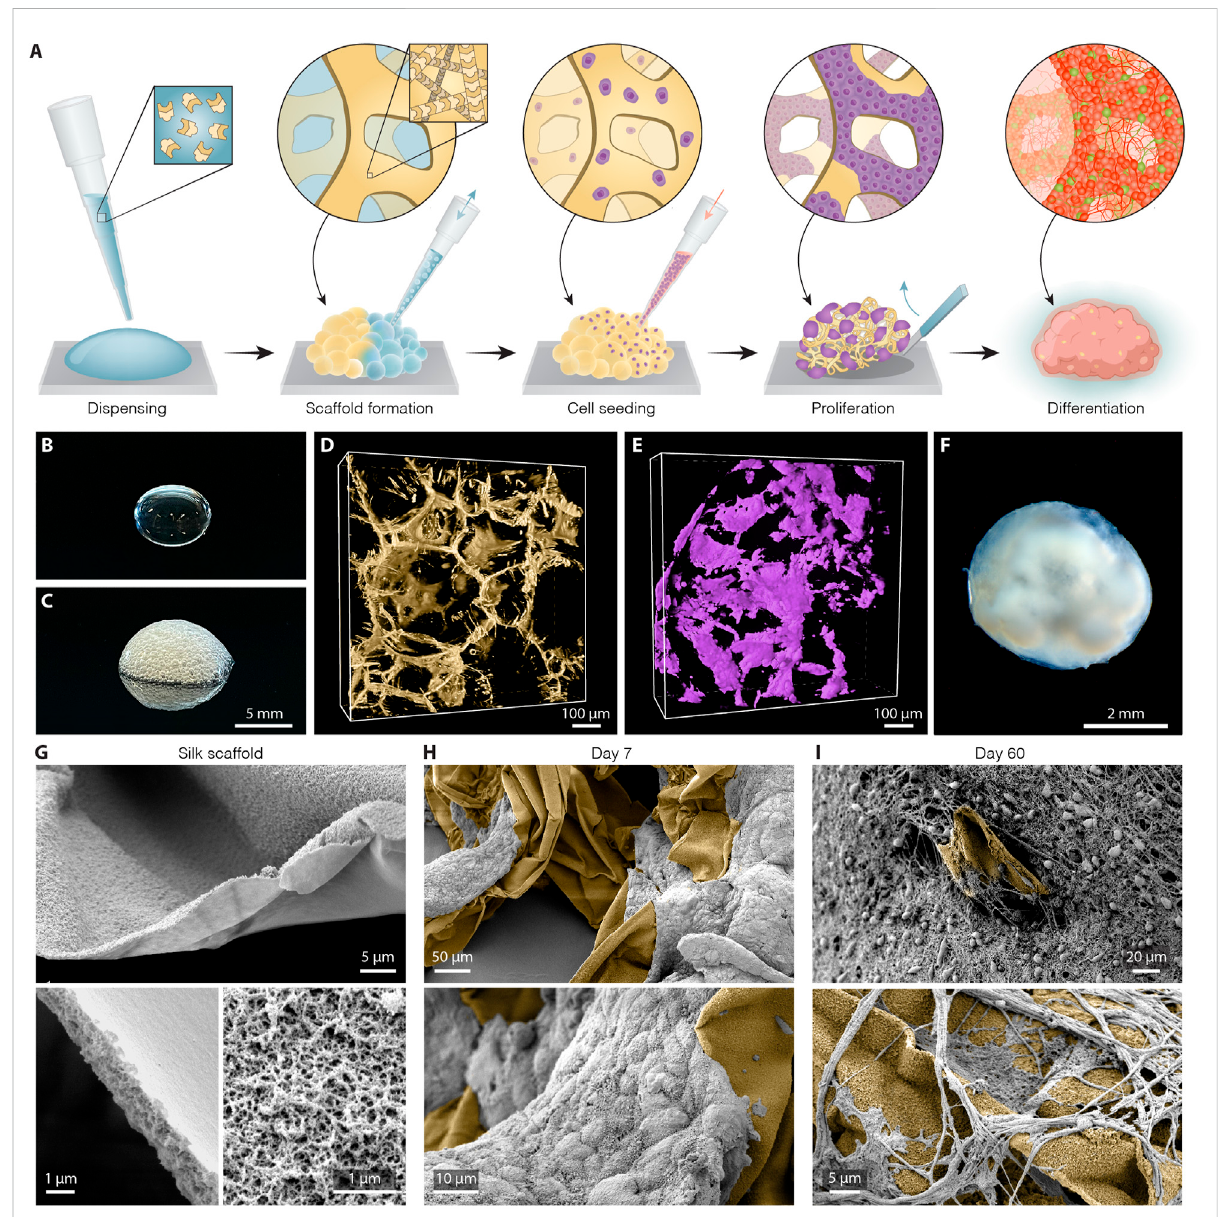
FIGURE 1 Generation of silk human cerebral organoids. (A) Schematic overview of silk scaffolding strategy for generation of silk human brain organoid. (B,C) Representative image of silk (B) in a liquid form as a droplet and (C) as a foam after introduction of air bubbles. Scale bar 5 mm. (D) Representative view of confocal fl uorescence image stack of the polymerized silk scaffold (yellow) on day 5 of differentiation. Scale bar 100 µm. (E) Confocal image reconstructing in 3D live hPSCs (lilac) seeded along the silk fi ber network. Scale bar 100 µm. (F) Representative bright- fi eld image of long-term silk cerebral organoid culture (120 days). Scale bar 2 mm. (G) Scanning electron images (SEM) of silk scaffold without cells showing polymerized silk micro fi bers built up of nano fi brils. Scale bars 5 µm (top), 1 µm (bottom). (H) SEM images showing adherence and growth of hPSCs (grey) along the length of silk micro fi bers (yellow) at day 7. Scale bars 50 µm (top), 10 µm (bottom). (I) SEM images showing silk scaffold (yellow) with adherent neuronal cells and formation of intricate axon projections within silk engineered human cerebral organoids at day 60. Scale bars 20 µm (top), 5 µm